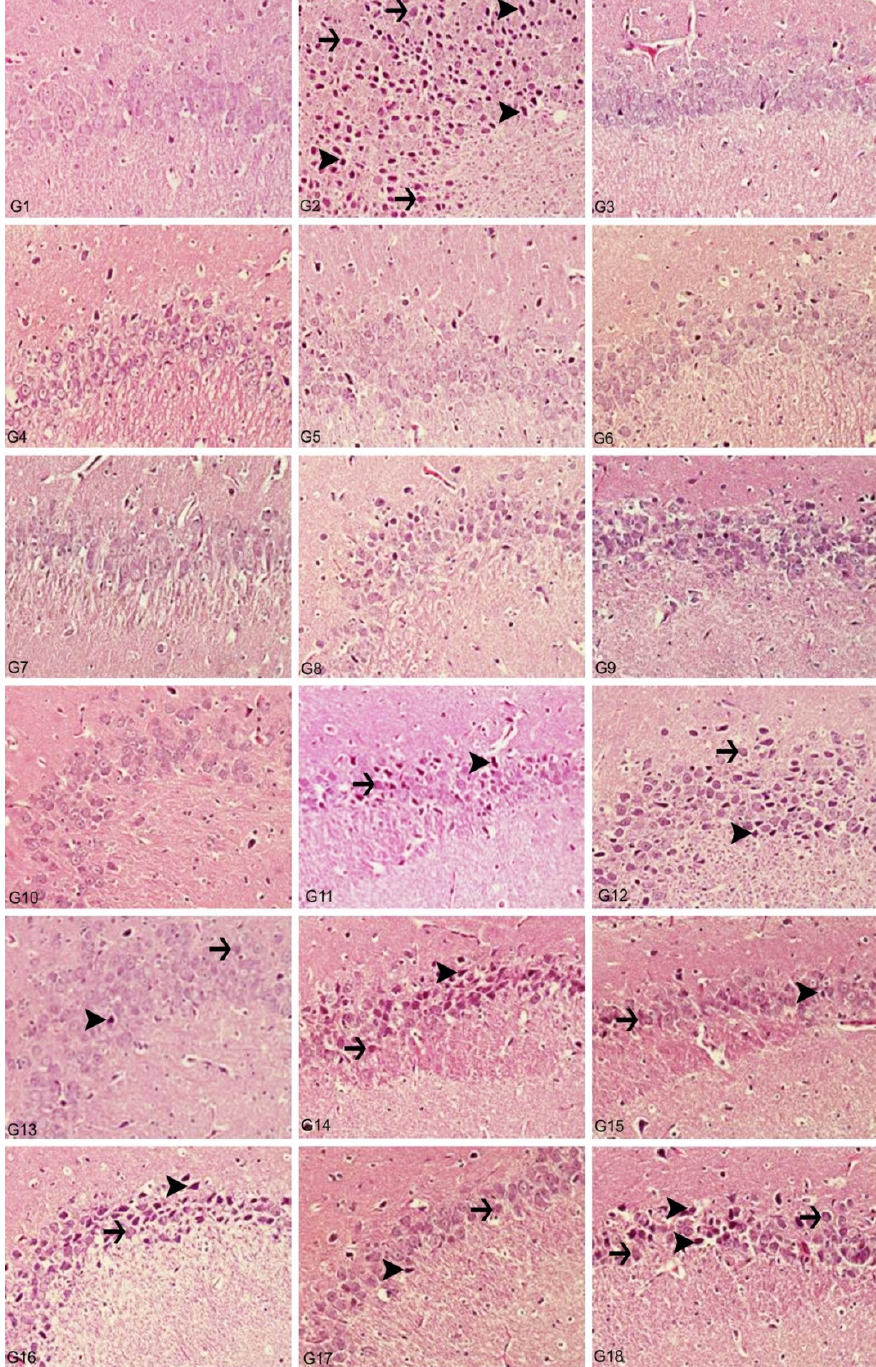
Figure 10. Hippocampus, degeneration in creatures (arrows), necrosis (arrowheads), hyperemia, H&E, 40X. (1) Control group, (2) Al-treated group for 30 days (as AlCl 3 , 4.2 mg/kg b.w.), (3) BA-treated group for 30 days (3.25 mg/kg b.w.), (4) BA-treated group for 30 days (6.5 mg/kg b.w.), (5) BX-treated group for 30 days (3.25 mg/kg b.w.), (6) BX-treated group for 30 days (6.5 mg/kg b.w.), (7) Col-treated group for 30 days (3.25 mg/kg b.w.), (8) Col-treated group for 30 days (6.5 mg/kg b.w.), (9) UX-treated group for 30 days (3.25 mg/kg b.w.), (10) UX-treated group for 30 days (6.5 mg/kg b.w.), (11) co-application of 3.25 mg/kg BA and 4.2 mg/kg Al, (12) co-application of 6.5 mg/kg BA and 4.2 mg/kg Al, (13) co-application of 3.25 mg/kg BX and 4.2 mg/kg Al, (14) co-application of